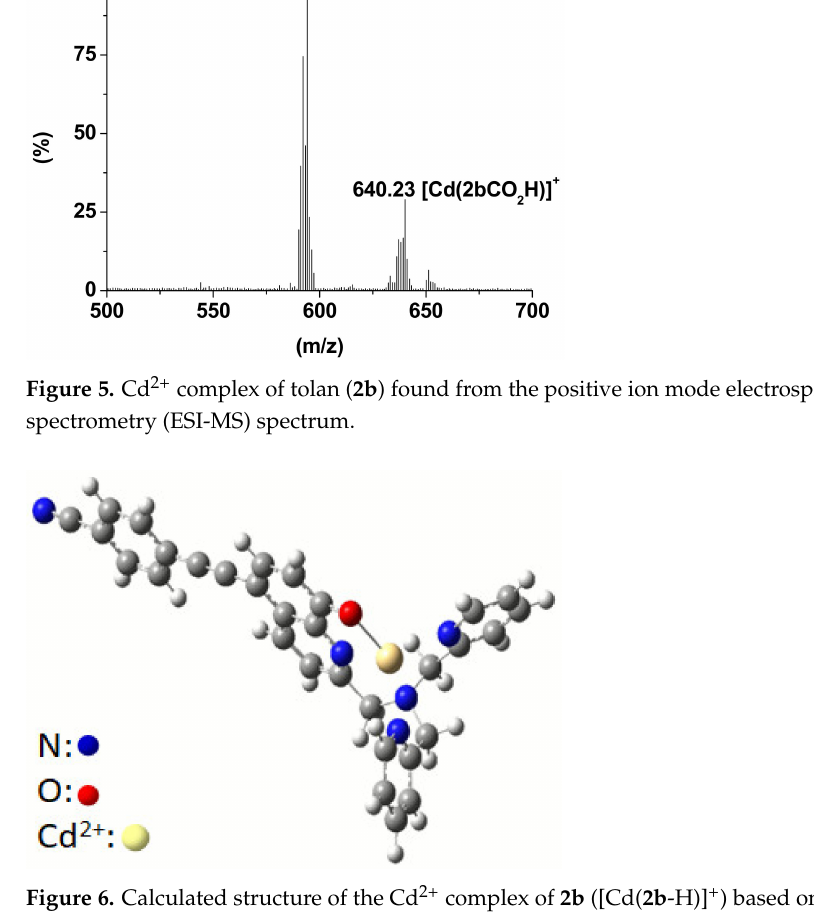
Figure 6. Calculated structure of the Cd 2+ complex of 2b ([Cd( 2b -H)] + ) based on density functional theory